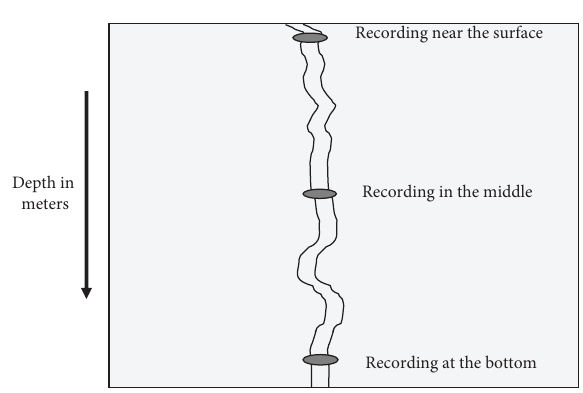
Figure 2: Sampling depth interval at each collection